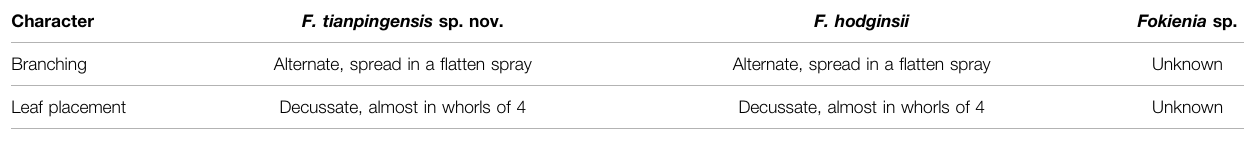
TABLE 1 | Comparison of Fokienia tianpingensis sp. nov. with another fossil species and extant Fokienia hodginsii